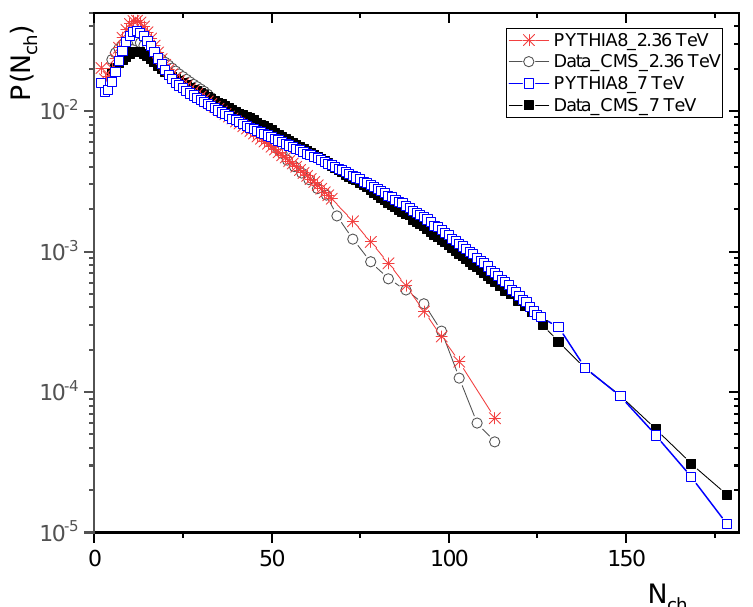
√ s = 2.36 TeV and 7 TeV